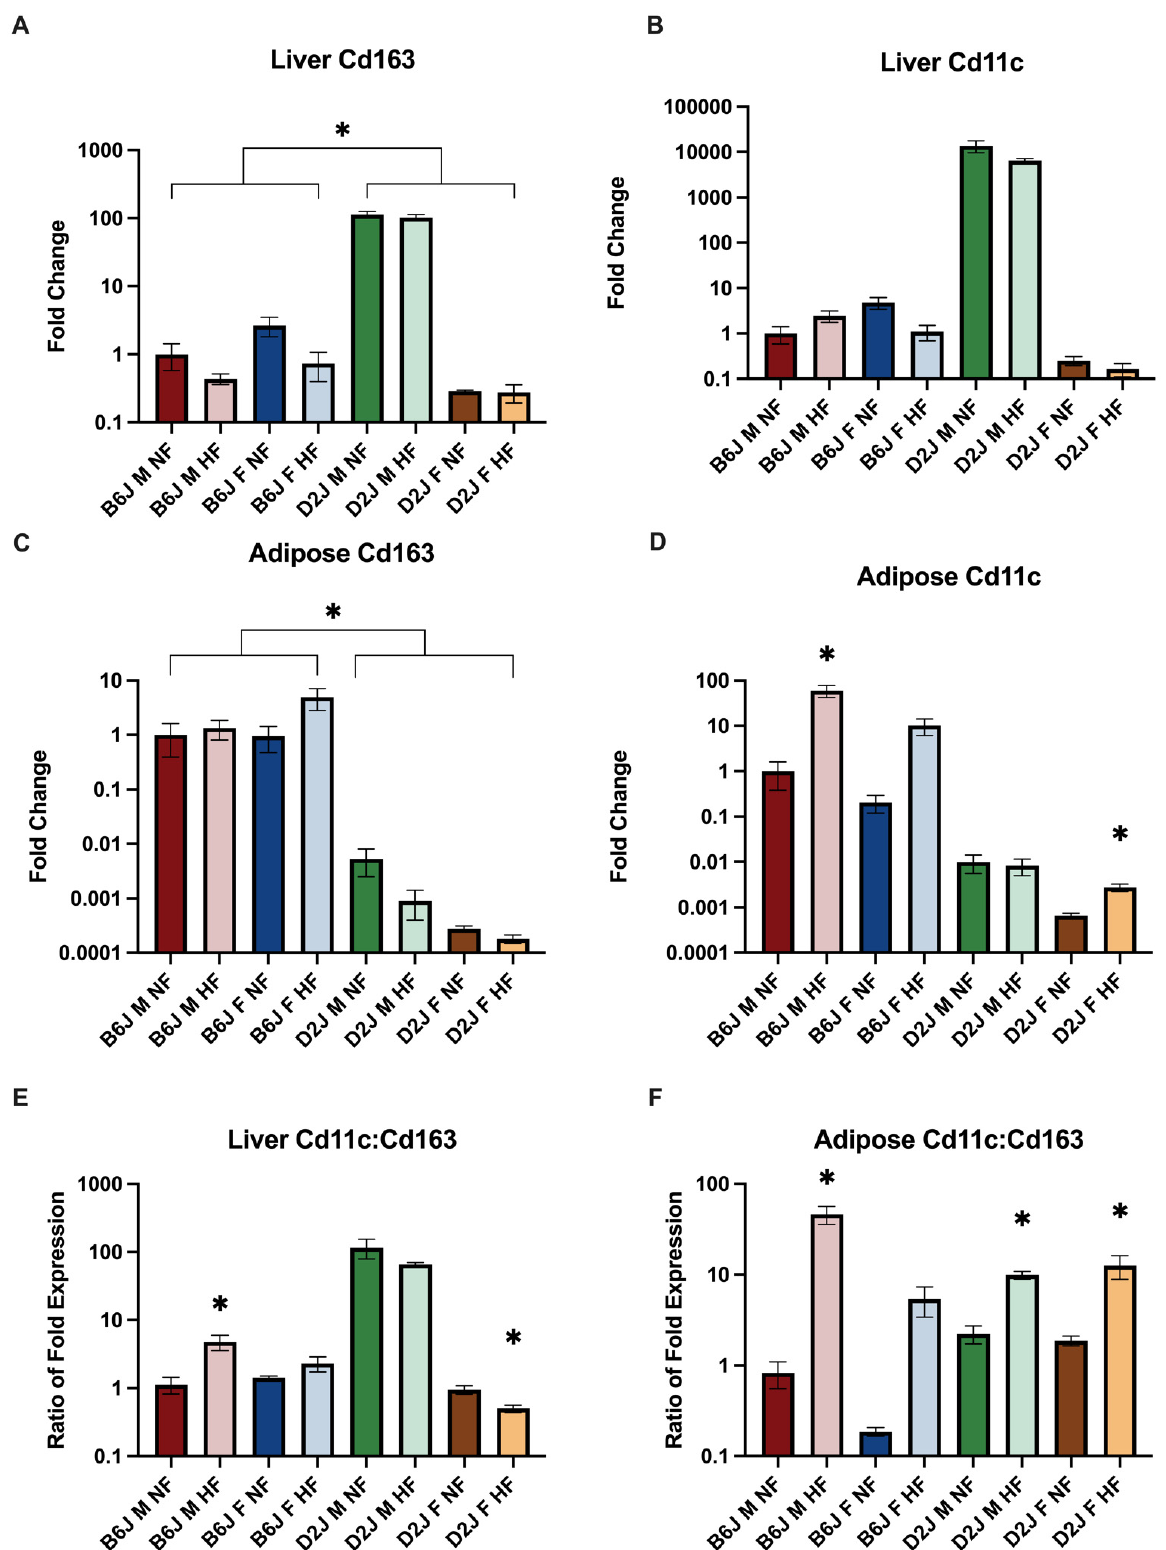
Figure 5. The effect of diet, sex, and strain on gene expression of repair and inflammatory macrophage phenotypes in liver and adipose tissue. Gene expression is expressed as fold change normalized to the B6J male normal fat biological group for ( A ) liver Cd163, ( B ) liver Cd11c, ( C ) adipose Cd163, and ( D ) adipose Cd11c. Ratio of Cd11c to Cd163 expression is shown for ( E ) liver and ( F )